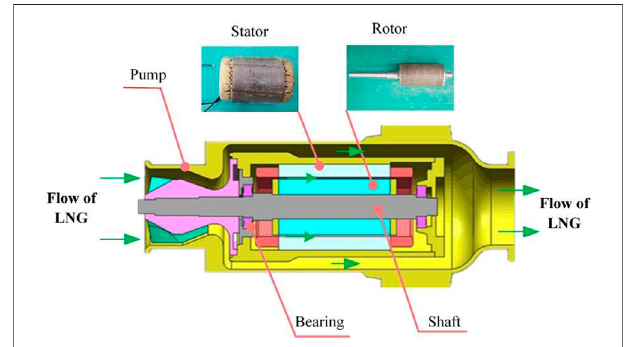
FIGURE 1 | Submerged LNG pump with the cryogenic motor.